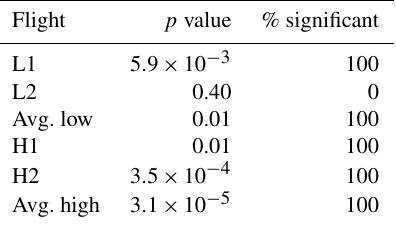
Table 5. The mean p value and the percent of data that are statis- tically significant (for the first 60 PCF values) between edge and center data for L1, L2, H1, and H2 in Fig. 5 and for average low and high in Fig.